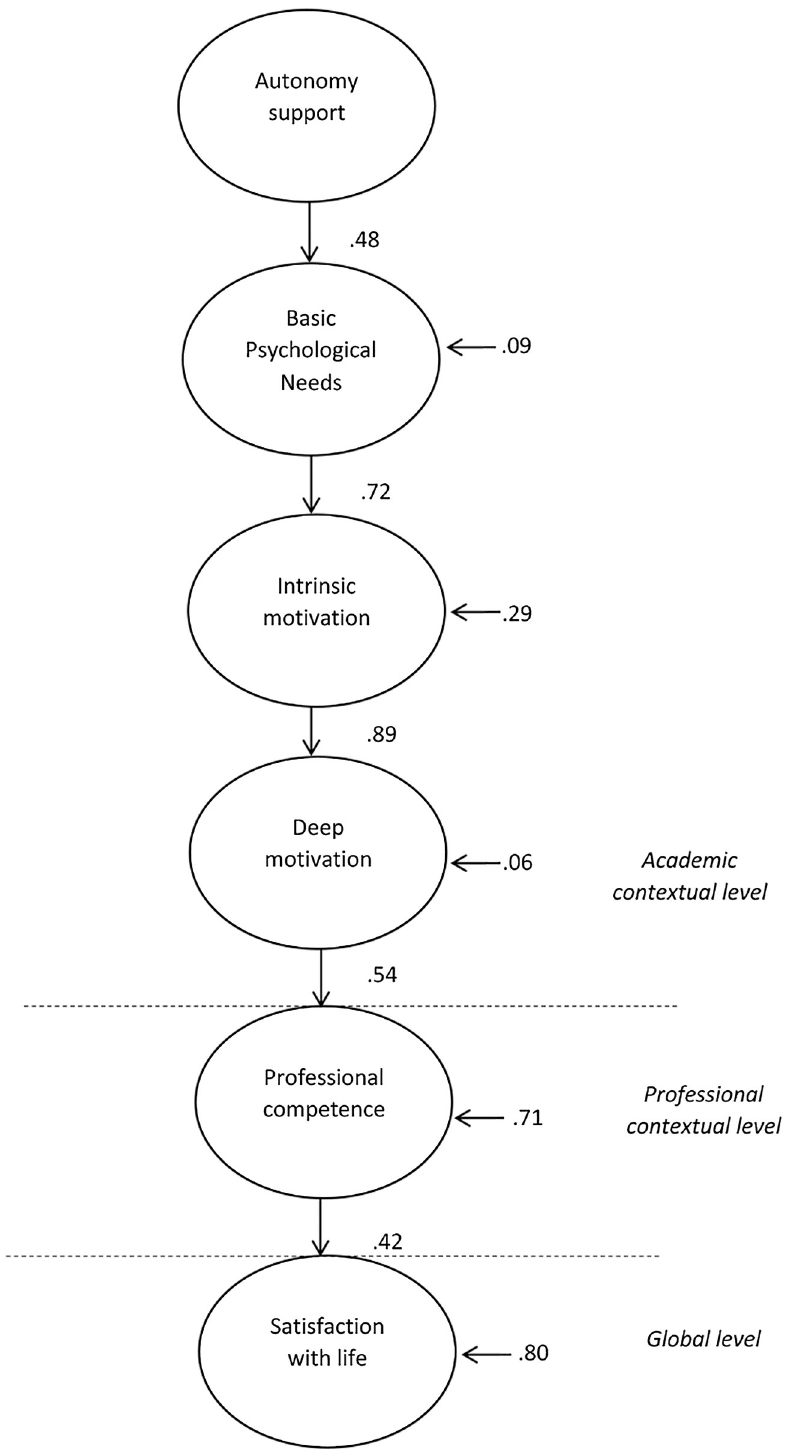
Fig 1. Structural equation model. Parameters are significant at p < .05 and standardized.